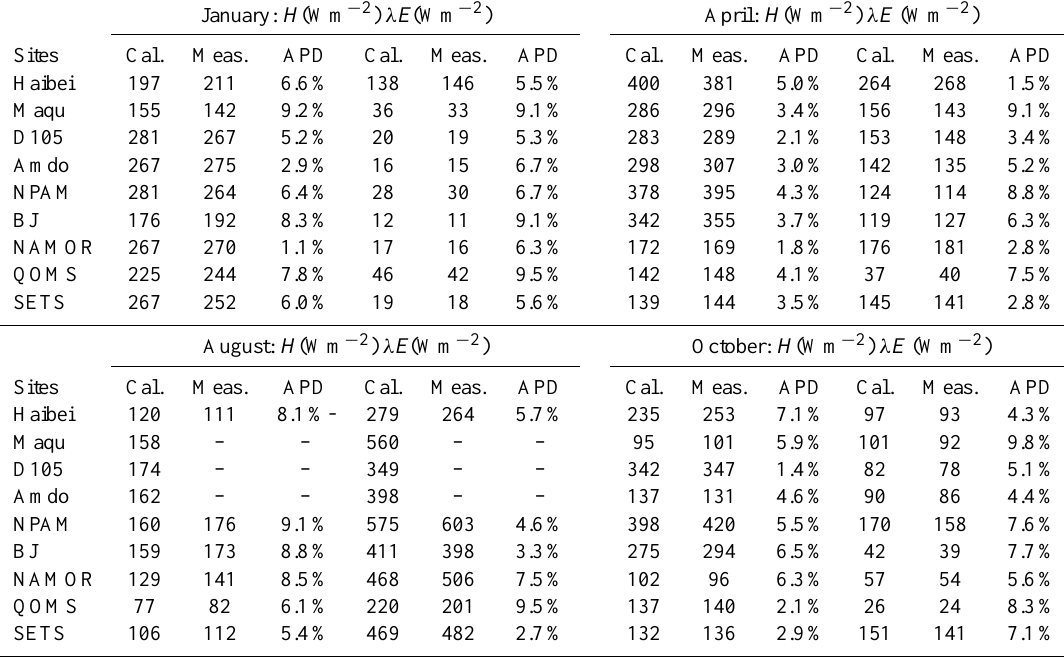
Table 2. Comparison of the derived sensible heat flux and latent heat flux (Cal.) versus the values measured (Meas.) at the Tibetan Plateau with absolute percent difference (APD).